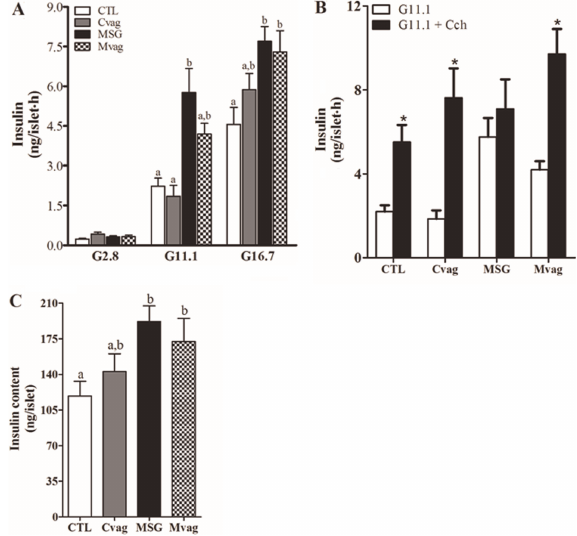
Figure3. Glucose( A )andcarbachol(Cch)-inducedinsulinsecretion ( B ), and total insulin content ( C ) of islets from 90-day-old CTL, Cvag, MSG and Mvag rats. Groups of 4 islets were incubated for 1 h with increasing glucose ( G ) concentrations, as indicated in the legend or in the presence of 11.1 mM glucose without or with 100 m M Cch. CTL: control; Cvag: CTL with subdiaphragmatic vagotomy; MSG: monosodium glutamate; Mvag: MSG with subdiaphragmatic vagot- omy. Data are reported as means±SE obtained from 16 groups of islets. Different letters indicate statistically significant differences (two-way ANOVA followed by Duncan’s post-test, P # 0.05). *G11.1++Cch was different from G11.1 in the same group of islets evaluated (Student’s t -test; P #